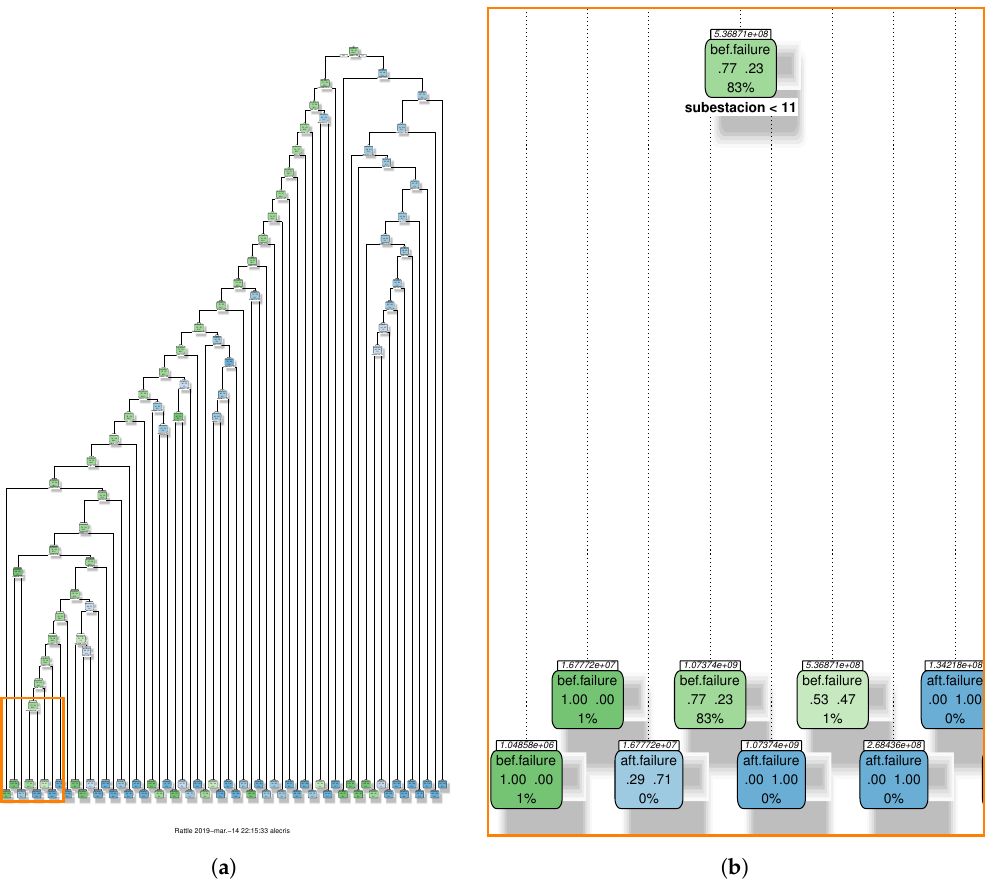
Figure 5. Decision tree result for the generator failures ( a ). The model was generated with the words that have a frequency from 1% to 90%. This range is a good trade-off for each of the metrics of Figure 6. The zoomed panel ( b ) shows that with only the word subestacion almost the 83% of the observations are classified as “before